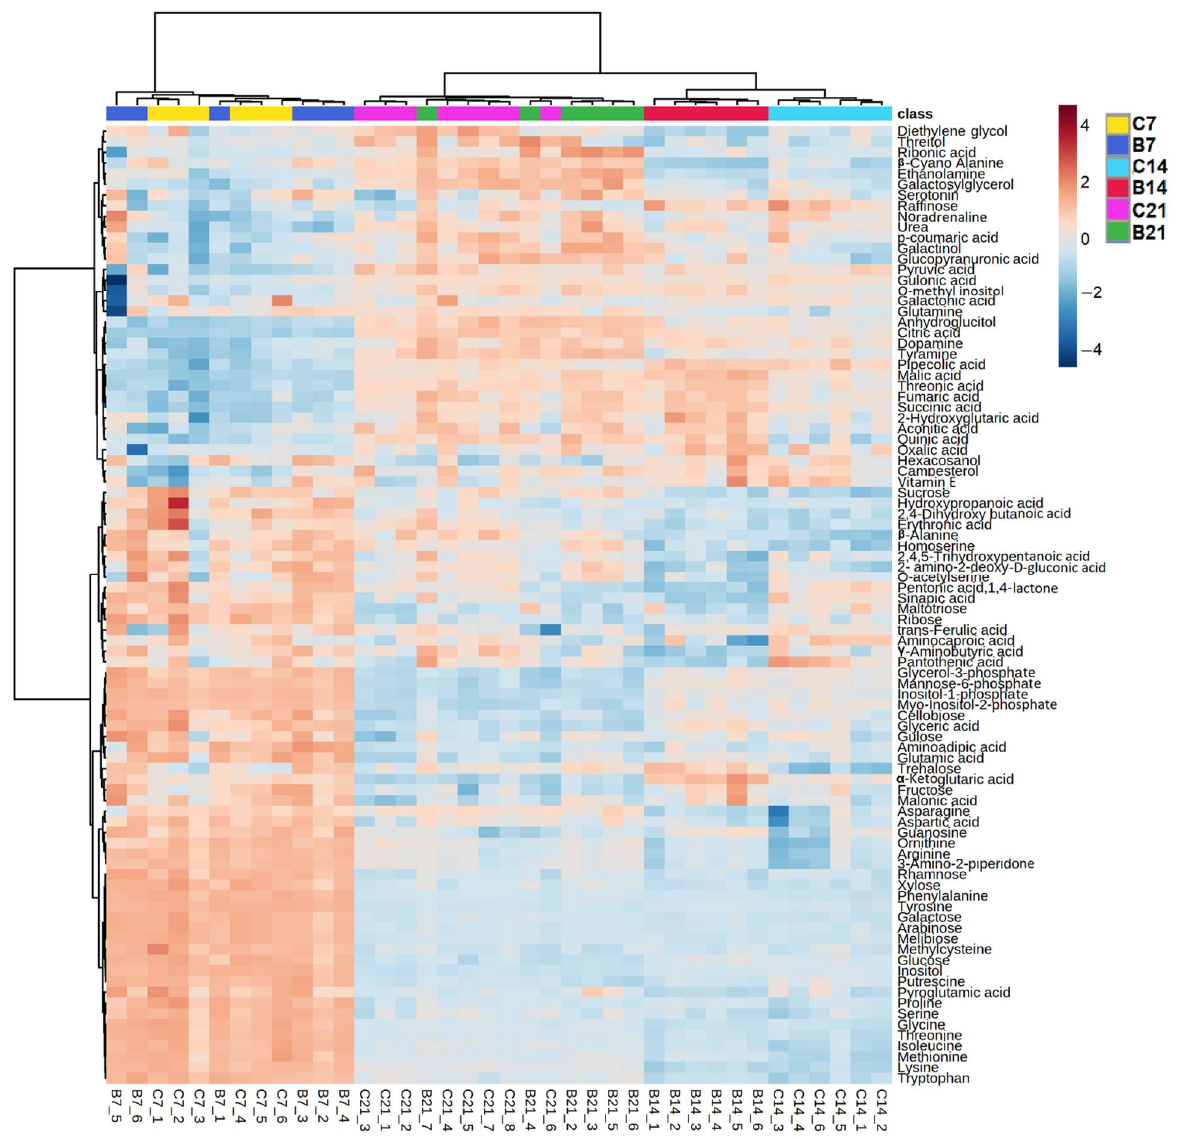
Figure 2. Hierarchical clustering coupled with heatmap of the polar metabolite profiles of Azospirillum-inoculated (B) and non-inoculated roots (C) of Brachypodium harvested at 7, 14, and 21 DAI. The lettering at the bottom of the heatmap indicates the replicates: for each replicate, blue and red colors indicate the lower or higher abundance of specific metabolites respectively compared to the other replicates, with darker colors indicating more pronounced differences.